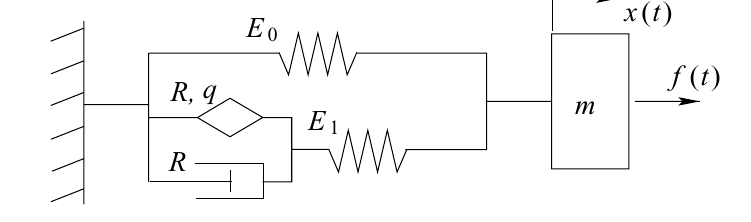
Fig. 4. Mass attached to extended 3-parameter material